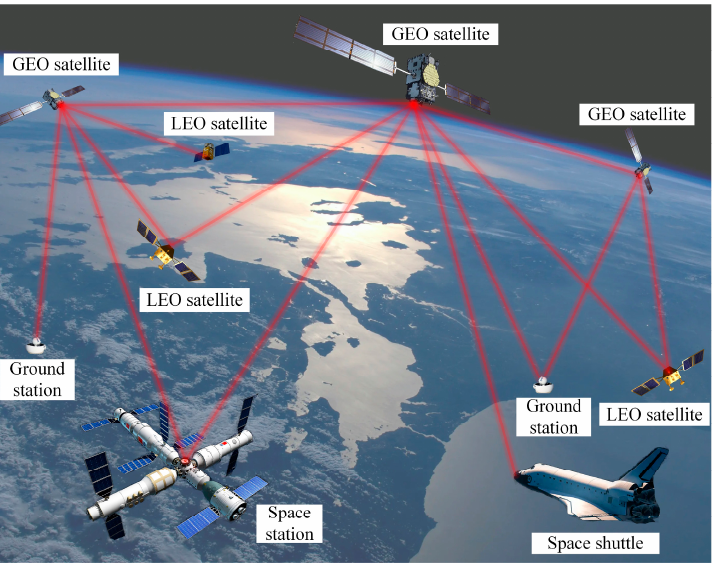
Figure 1. The illustration of a space laser communication networking structure.